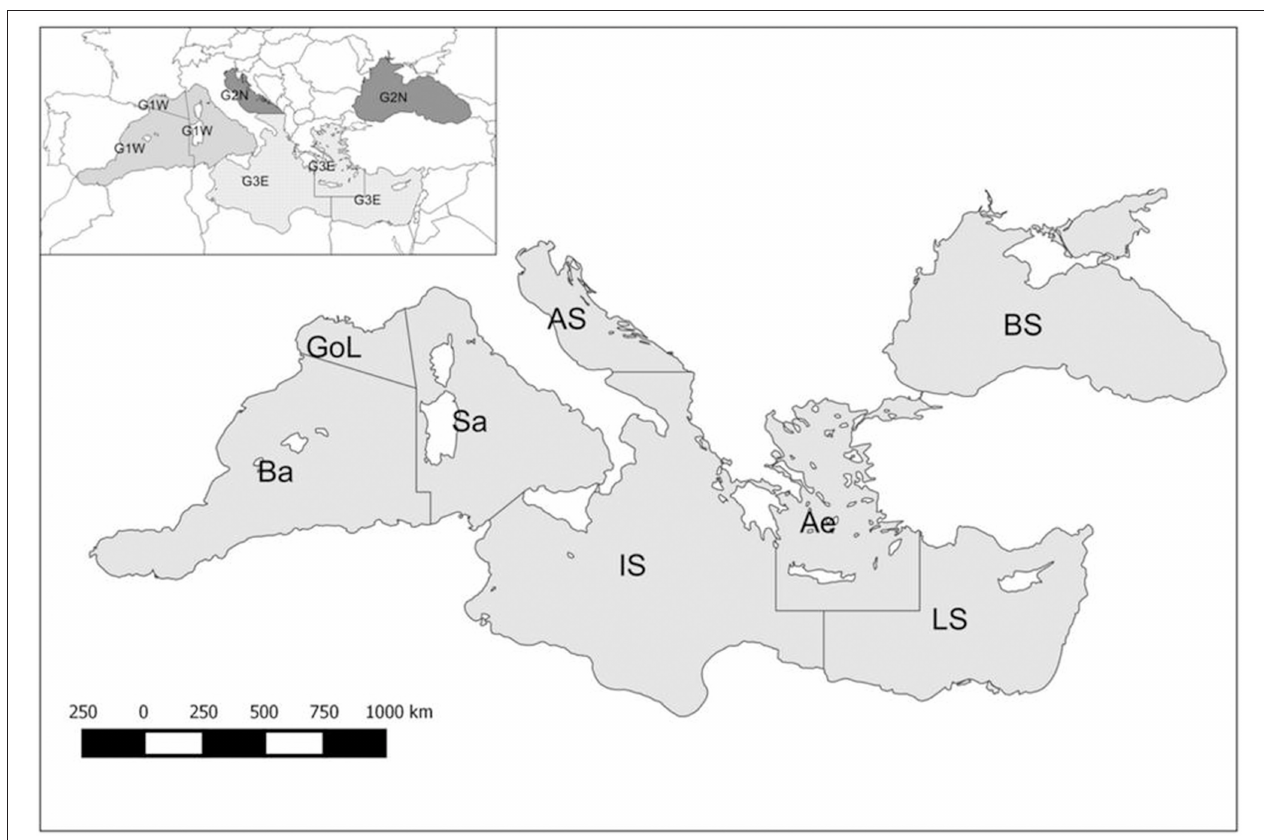
FIGURE 1 | The Mediterranean basin showing the eight FAO-areas and the aggregation in three macro-areas. Ba, Balearic Sea; GoL, Gulf of Lion; Sa, Sardinia; IS, Ionian Sea; AS, Adriatic Sea; Ae, Aegean Sea; LS, Levantine Sea; BS, Black Sea; G1W, macroarea West (mid-gray); G2N, macroarea North (dark-gray); G3E, macroarea East